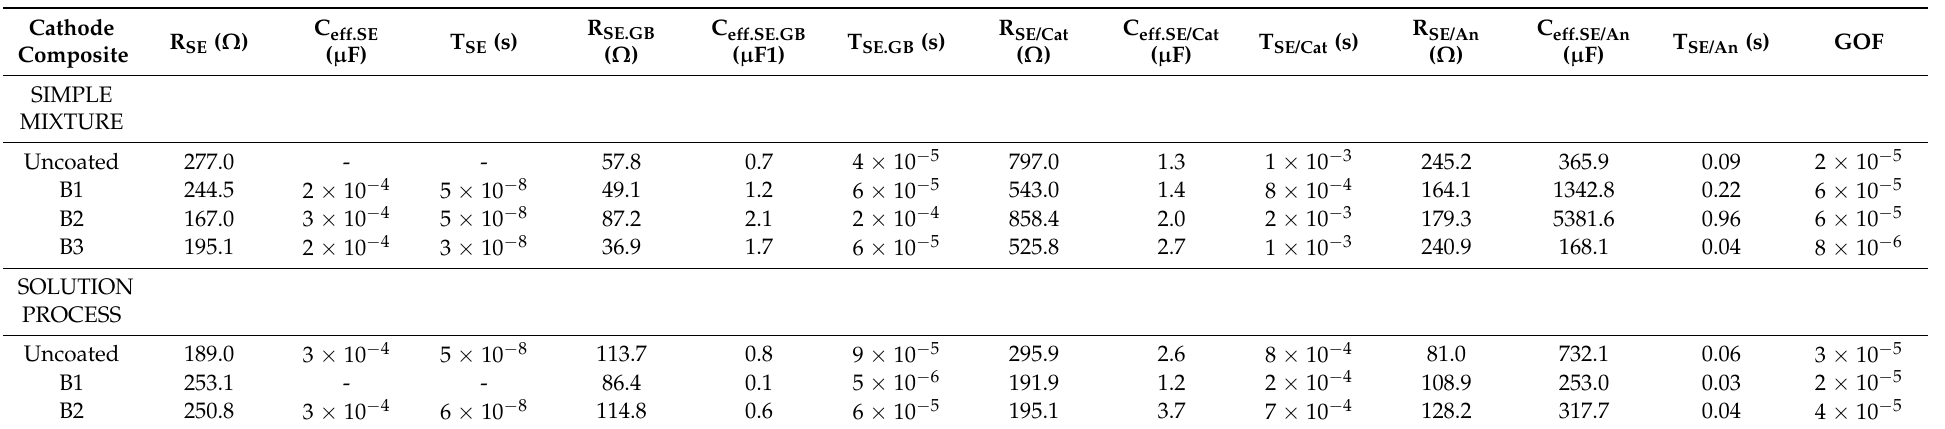
Table 2. Fitting results of impedance spectra (Figure 5) with the composite electrodes with 80Li 2 S · 20P 2 S 5 solid electrolytes prepared via simple mixture and solution processes at the 2nd charge cycle. GOF: goodness of fit (discrepancy between model and experimental values of impedance spectra). Cathode